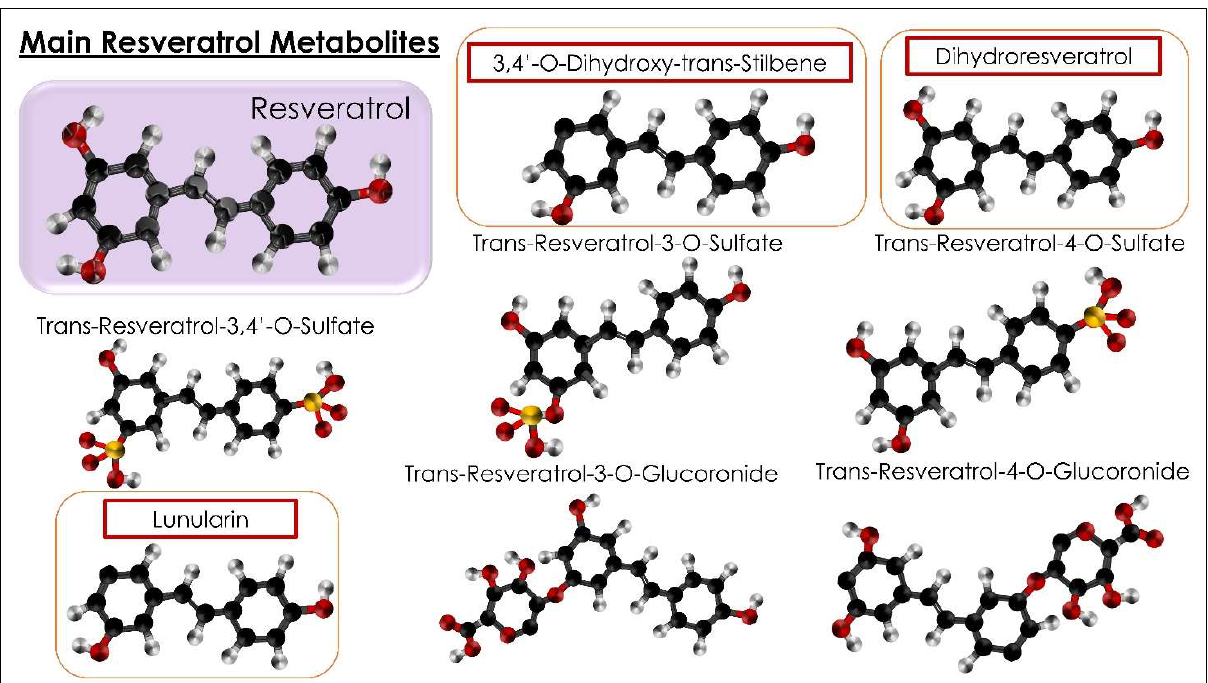
Figure 1. Summary of the RSV metabolites and the main molecules indicated for their antioxidant and anti-inflammatory bioactivity.